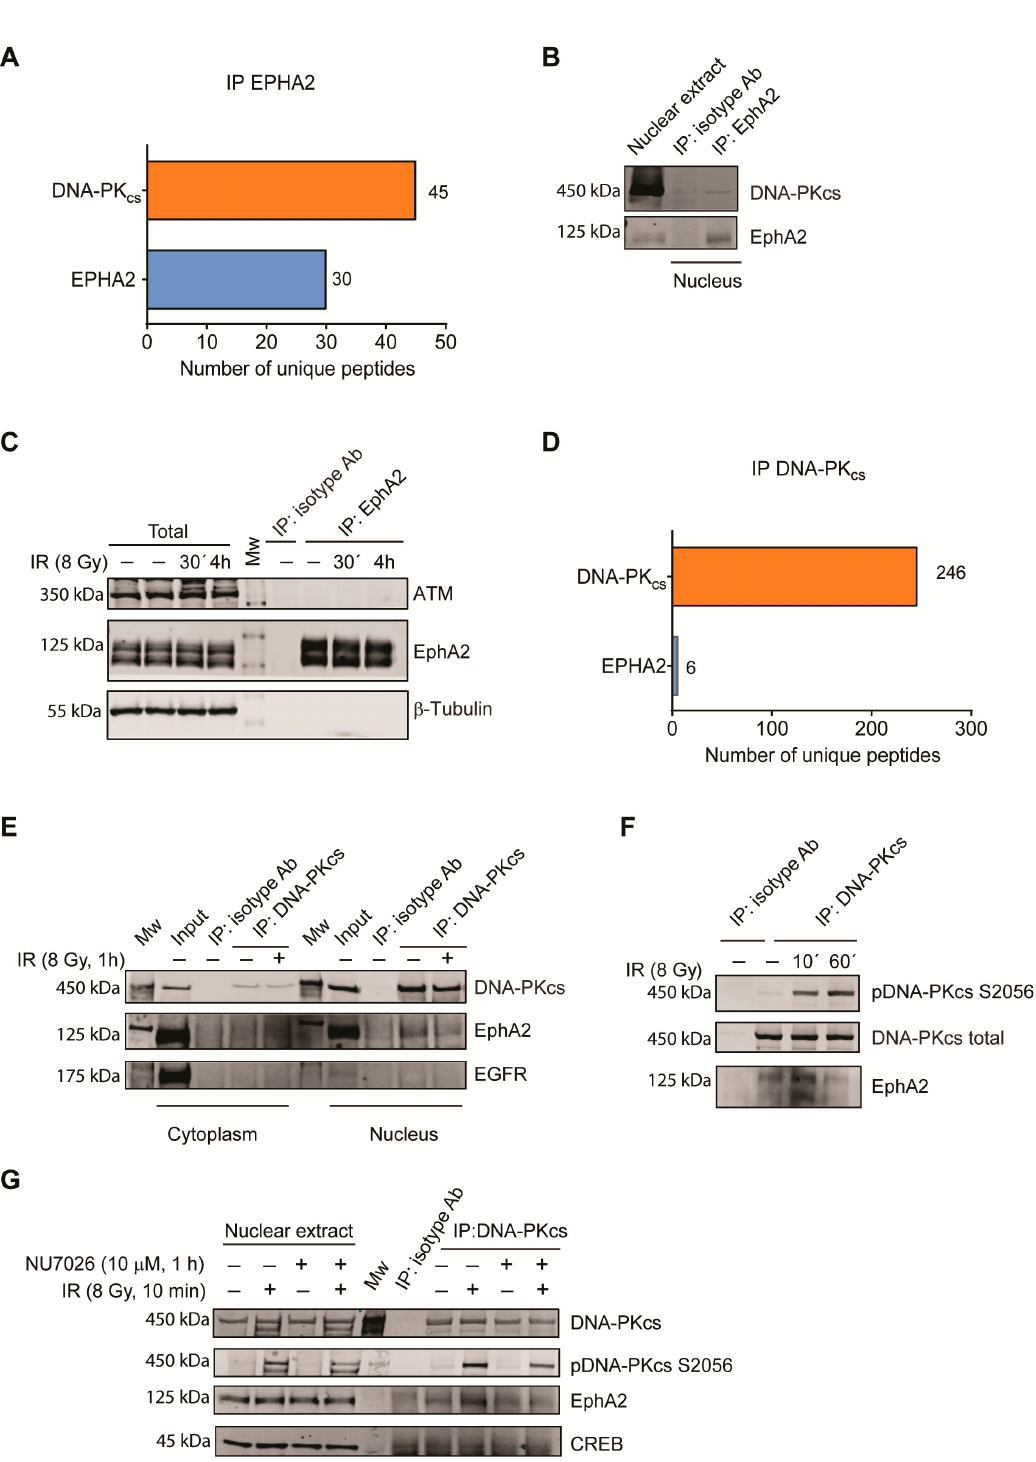
Figure 4. DNA-PK cs interacts with EphA2 in cell nucleus. ( A ) EphA2 was immunoprecipitated (IP) from nuclear extracts of U-1810 cells. The number of EphA2 and DNA-PK cs unique tryptic peptides identified by LC-MS/MS analysis is shown. The peptides identified for EphA2 or DNA-PK cs are given in Data S1. ( B ) Nuclear extract was prepared from U-1810 cells and the extract volume was divided equally into two parts. IP was performed using either isotype control rabbit IgG or EphA2 antibody. Expression of DNA-PK cs and EphA2 was analyzed by immunoblotting. ( C ) IP of EphA2 from U-1810 total cell lysates was performed using EphA2 antibody or rabbit isotype antibody control. Expression of ATM and EphA2 was analyzed by immunoblotting with β -Tubulin used as a loading control for total cell extracts. ( D ) DNA-PK cs IPs from nuclear extracts of U-1810 cells. The number of EphA2 and DNA-PK cs unique tryptic peptides identified by LC-MS/MS analysis